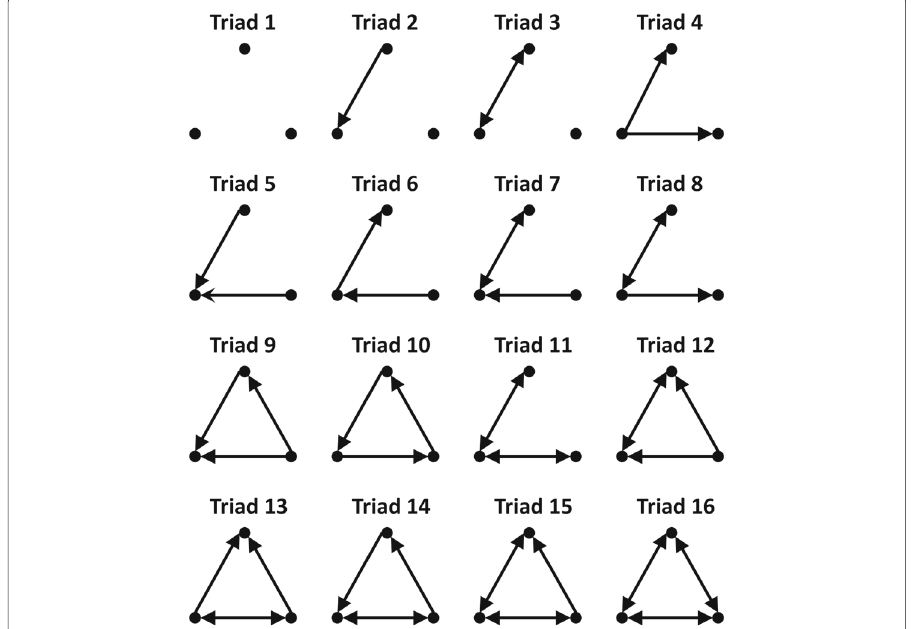
Fig. 2 Triadic Subgraphs. All nonisomorphic directed graphs consisting of three vertices. Subgraphs that occur at statistically high rates are called motifs. It is common in literature to ignore subgraphs 1, 2 and 3; however, we include them as possible transformation